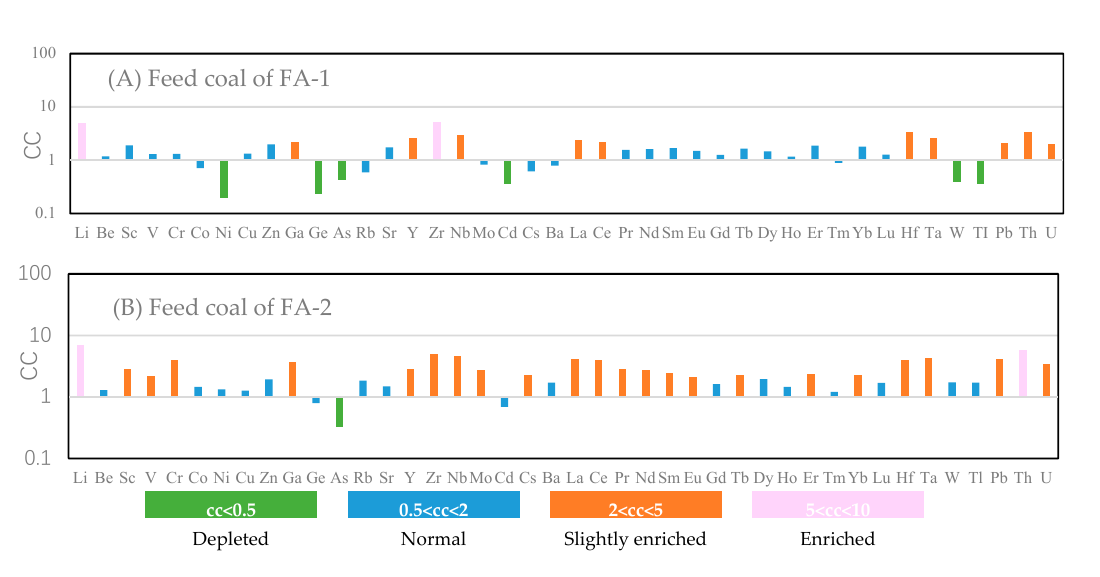
Figure 1. Concentration coefficients (CC) for trace elements in the feed coals for FA-1 and FA-2, normalized to average trace-element concentrations in world hard coals from Ketris and Yudovich, 2009 [47].